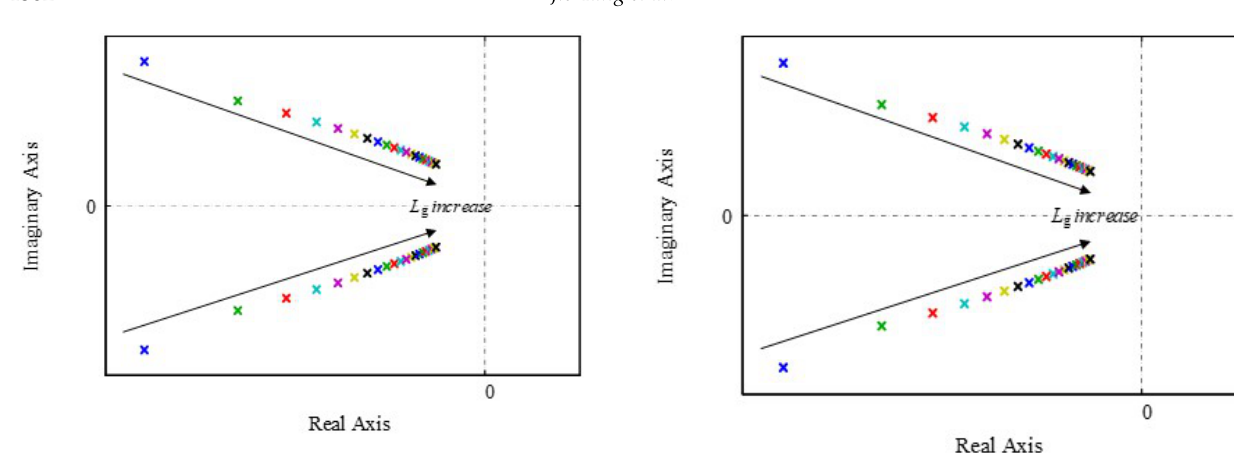
Fig. 16. Root locus of closed-loop dominant pole corresponding to grid-side current.